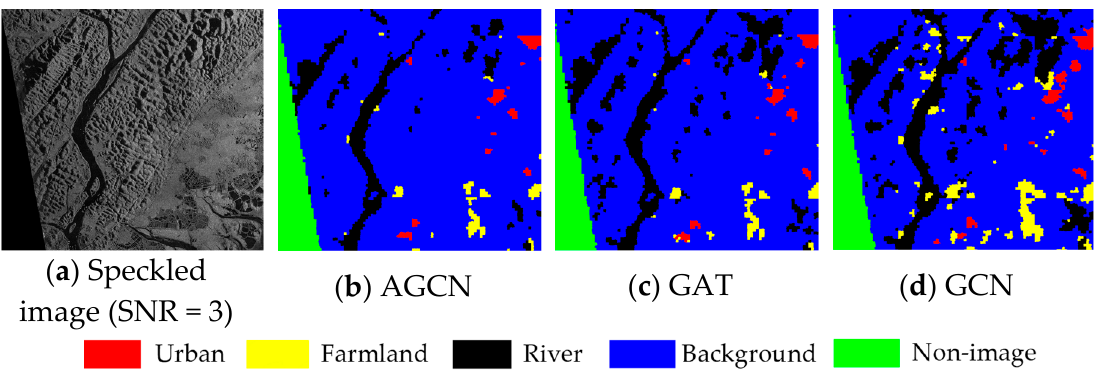
Figure 9. Segmentation results of three models for a speckled image. ( a ) Speckled image (SNR = 3); ( b ) AGCN ( c ) GAT; ( d ) GCN.